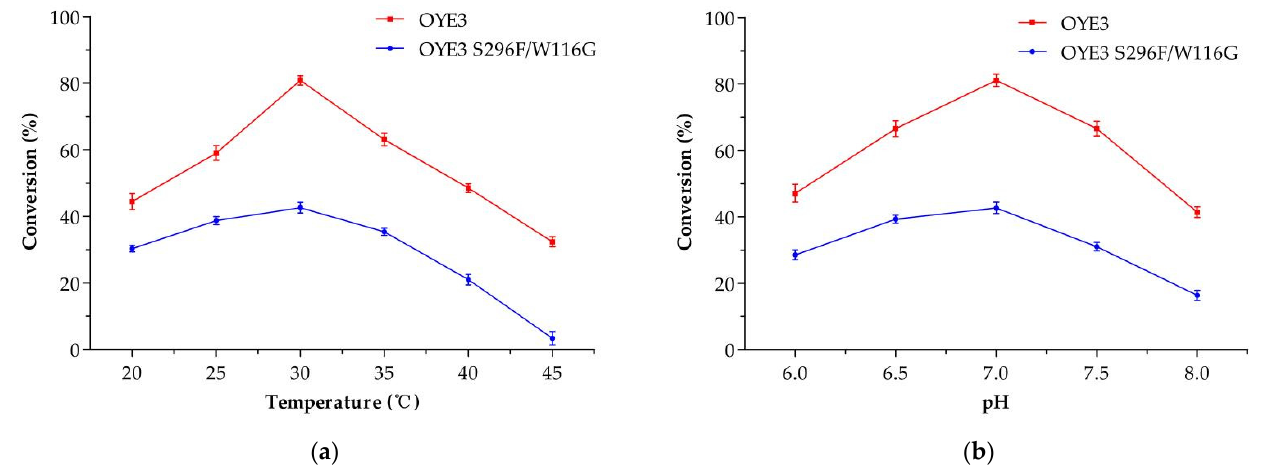
Figure 3. Determination of key factors affecting the asymmetric reduction of ( E/Z )-citral to ( R )-citronellal. The standard reaction mixture (10 mL) contained 20 mM ( E/Z )-citral, 0.6 mM NADP + , 0.15 U/mL GDH, 50 mM glucose, 0.15 U/mL of the variant S296F/W116G, and 50 mM PIPES buffer solution (pH 7.0). The stock solution of substrate was 200 mM citral dissolved in isopropanol. The reaction was conducted in a reactor with a pH auto-titration system at 400 rpm for 10 h (OYE3) or 18 h (the variant S296F/W116G). The temperature was investigated from 20 to 45 ℃ ( a ) and the pH values were explored from 6.0 to 8.0 ( b ). Data present mean values ± SD from three independent experiments. ( E / Z )-citral contained 58.4% geranial and 41.6% neral.